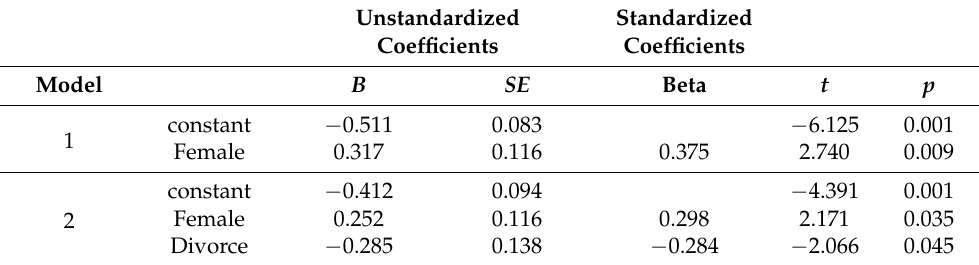
Table 6. Coefficients of stepwise regression.